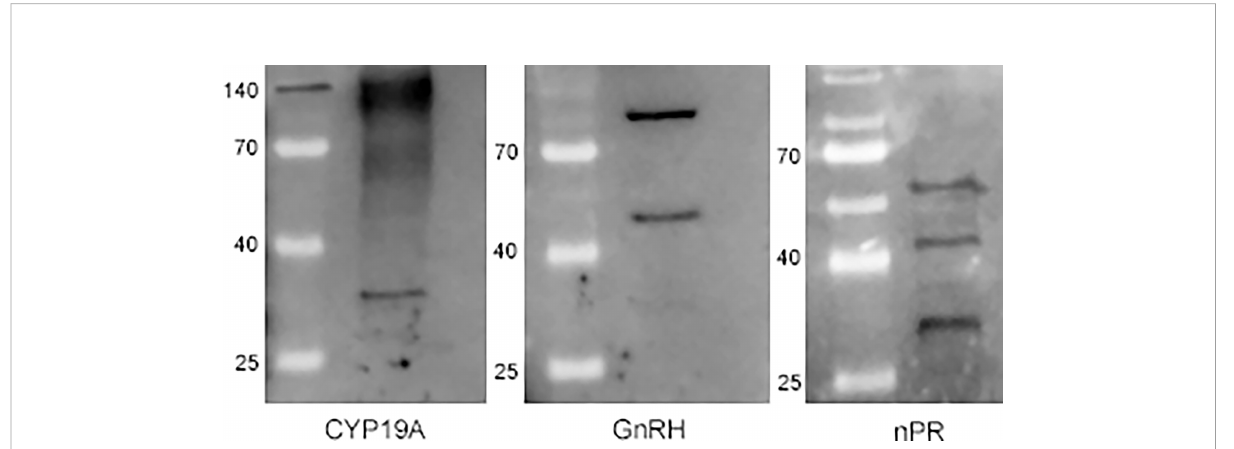
FIGURE 5 Western blot analysis of the CNS homogenate with the anti-human CYP19A, anti-human GnRH, and anti-human nPR antibodies. The anti- CYP19A antibody yielded one discrete (~30 kDa) and two amorphous (~65 kDa and ~140 kDa) bands, moreover, it marked the 140 kDa marker protein. The anti-GnRH antibody gave two discrete bands (~50 kDa and ~100 kDa), while the anti-nPR antibody resulted in three discrete bands (~30 kDa, ~50 kDa, and ~60